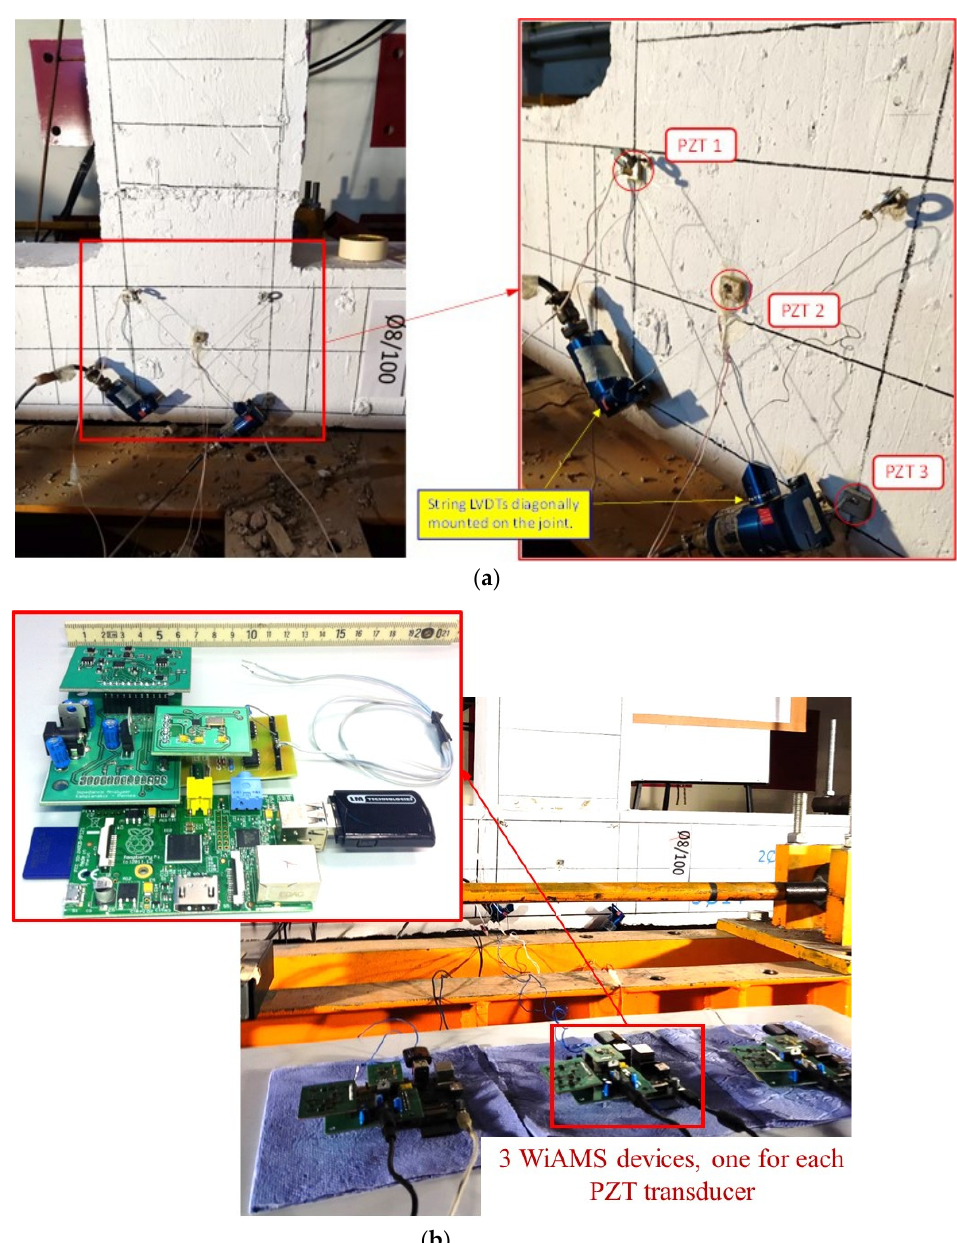
Figure 5. Measurement devices attached to specimen JC0: ( a ) Two diagonal SLVDTs and three epoxy-bonded PZT patches; ( b ) “Wireless impedance/Admittance Monitoring System (WiAMS)” devices, each one connected with two cables to the poles of each PZT patch mounted to the specimen, and detailed illustration of the small-sized SHM device.